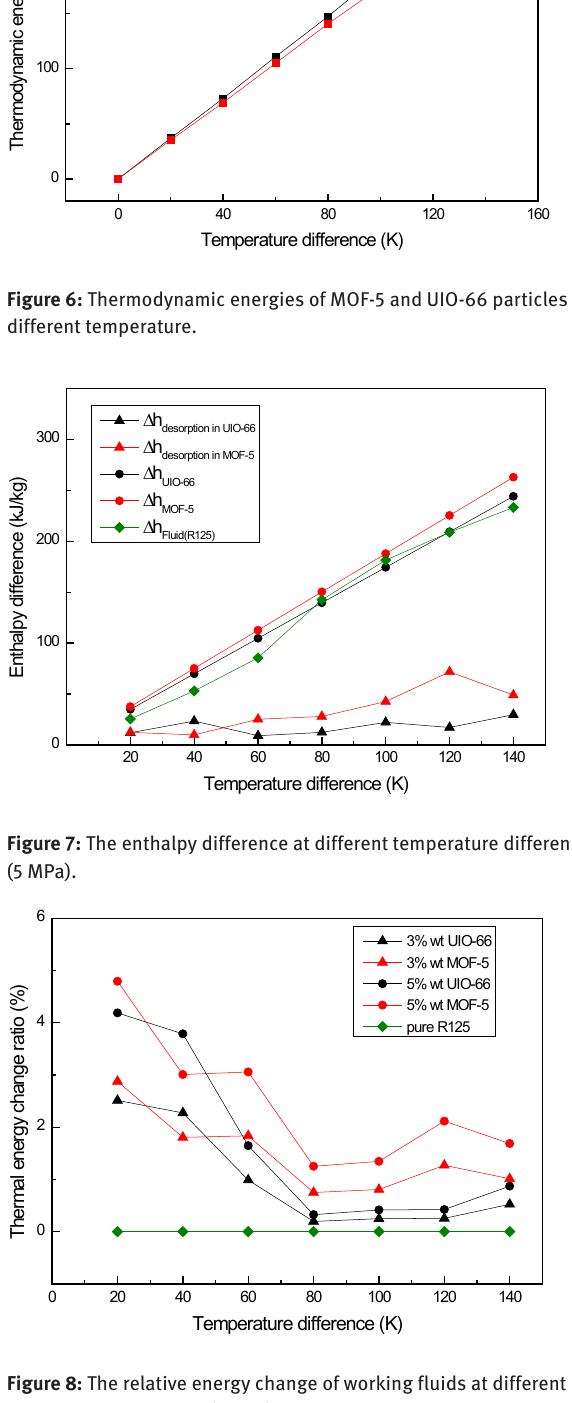
Figure 8: The relative energy change of working fluids at different temperature difference (5